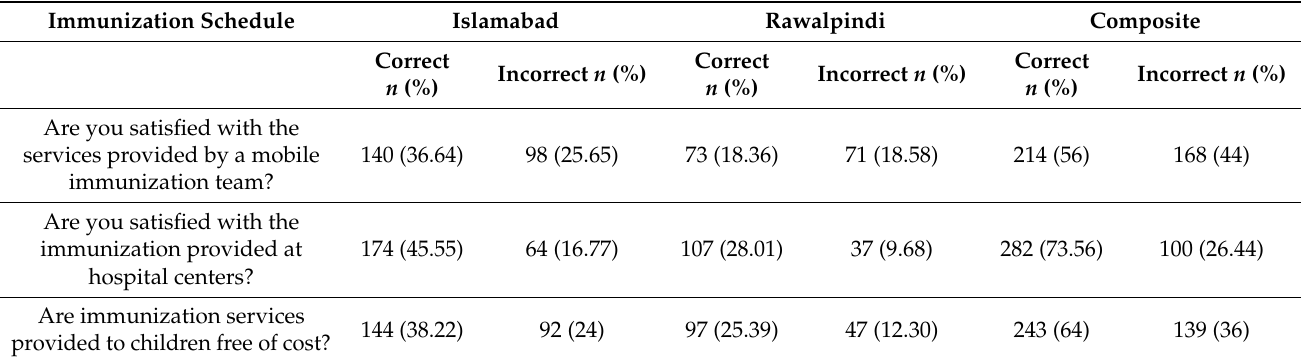
Table 6. Parents’ satisfaction with immunization services offered in Pakistan.